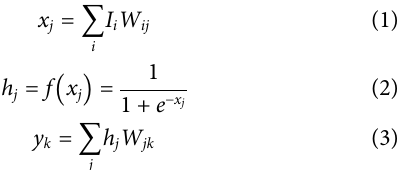
FIGURE 3 | SVM higher dimension